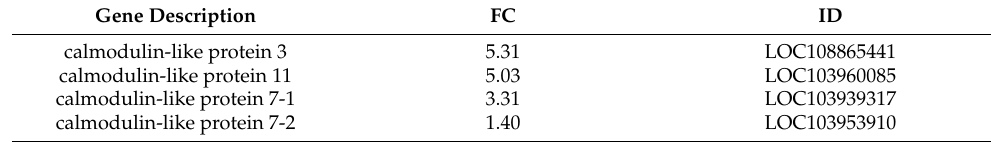
Table 1. Expression levels of calmodulin-like genes in watercore fruit using RNA-Seq.